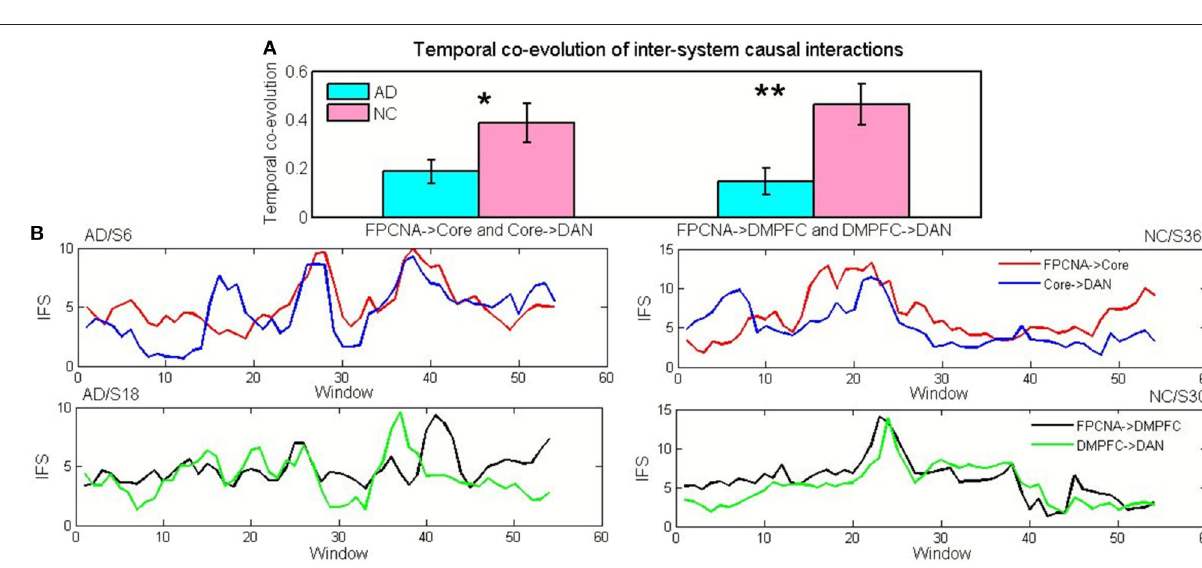
FIGURE 7 | Temporal co-evolution of inter-system causal interactions in the NC and AD groups. (A) Temporal co-evolution between FPCNA- > Core IFS and Core- > DAN IFS and between FPCNA- > DM IFS and DM- > DAN IFS in the NC and AD groups (* p < 0.05, ** p < 0.005). Error bars represent the standard error of the mean. (B) Data for four randomly chosen example participants demonstrating IFS from FPCNA to Core and IFS from Core to DAN (Top) as well as IFS from FPCNA to DM and IFS from DM to DAN (Bottom) within successive 60-second windows in the AD and NC